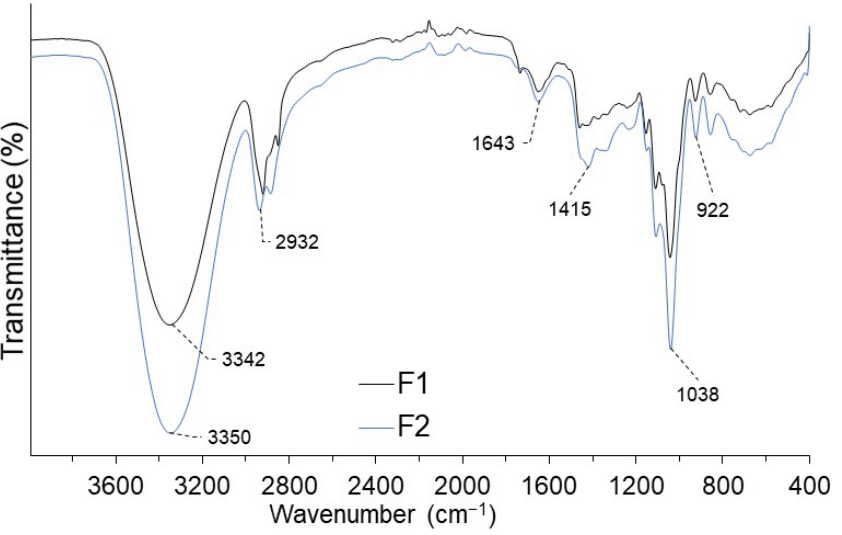
Figure 1. IR spectra for coating F1 and F2.